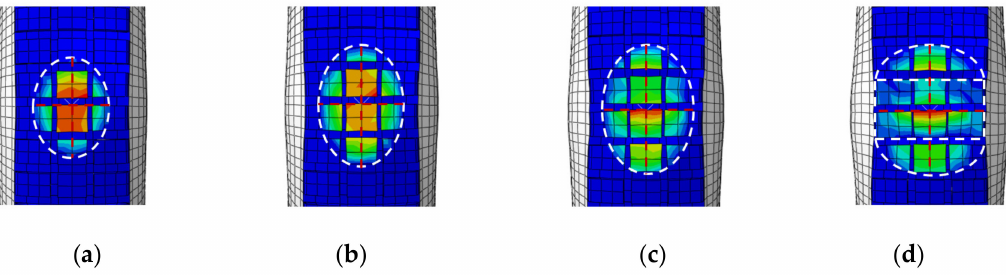
Figure 13. Footprint of truck tire: ( a ) δ = 10 mm; ( b ) δ = 15 mm; ( c ) δ = 20 mm; ( d ) δ = 25 mm.